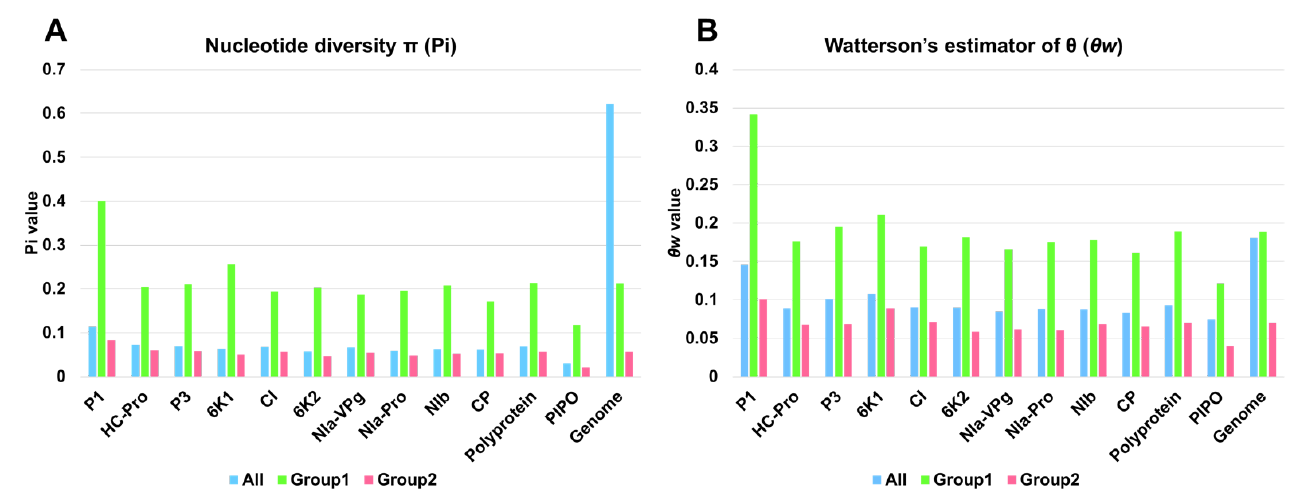
Figure 7. Genetic diversity of SMV proteins or genomes in different groups of SMV. Nucleotide diversity (Pi) ( A ) and average number of segregating sites ( θw ) ( B ) of individual SMV proteins or genomes in the three groups. ‘All’ indicates all 143 SMV genomes, and group 1 and group 2 include 6 and 137 SMV genomes, respectively.